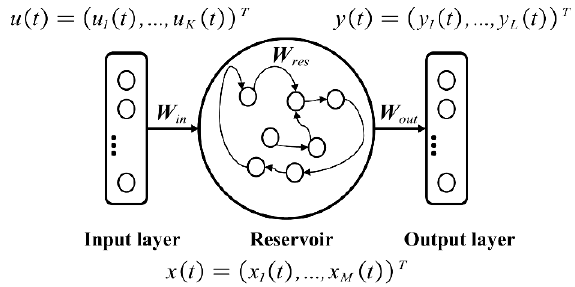
Figure 2. The ESN architecture.